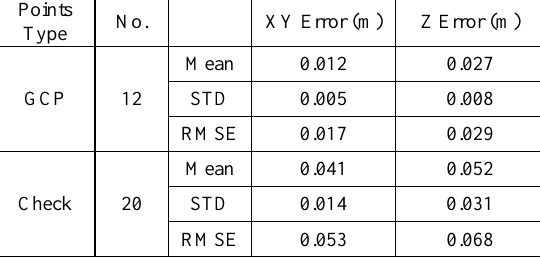
Table 2. Summary of spatial error in indirect georeferencing